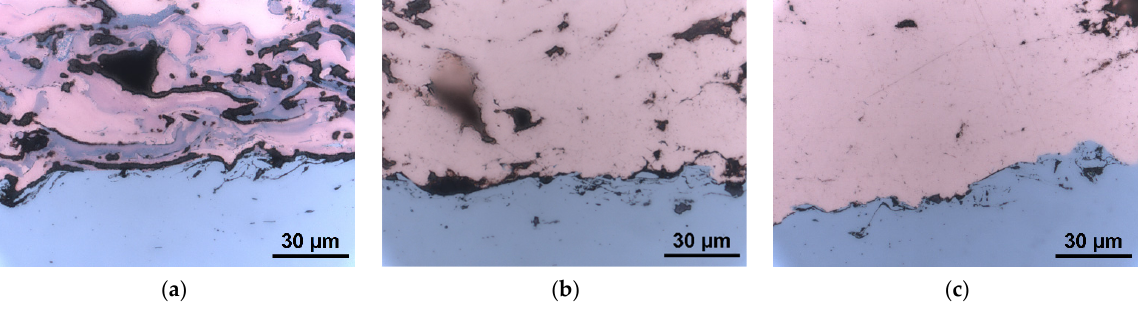
Figure 4. Optical micrographs revealing the interfacial gaps of wire arc copper coatings: ( a ) conventionally processed, i.e., blasted and sprayed in air; ( b ) blasted in air, sprayed in silane-doped nitrogen; and ( c ) blasted and sprayed in silane-doped nitrogen.